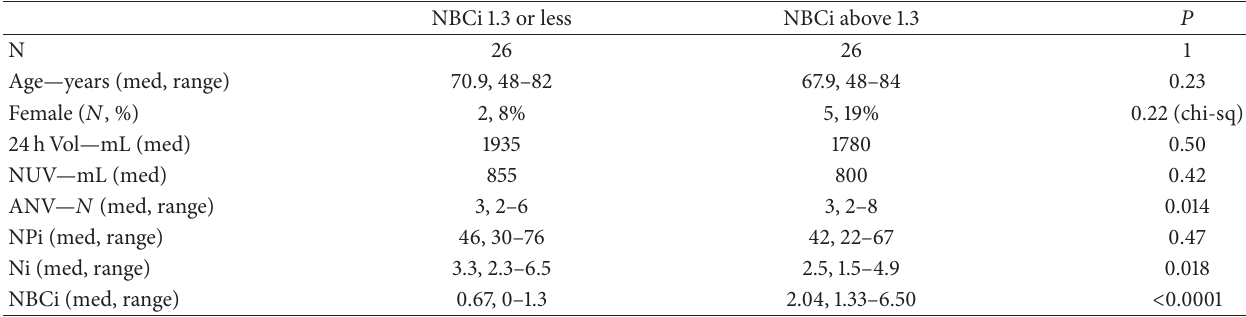
Table 1: Characteristics of patients who were prescribed desmopressin. Data were taken from medical history and frequency-volume chart they filled before treatment start. They are divided into two groups according to nocturnal bladder capacity index (NBCi): increased NBCi (above 1.3) and normal NBCi (1.3 or